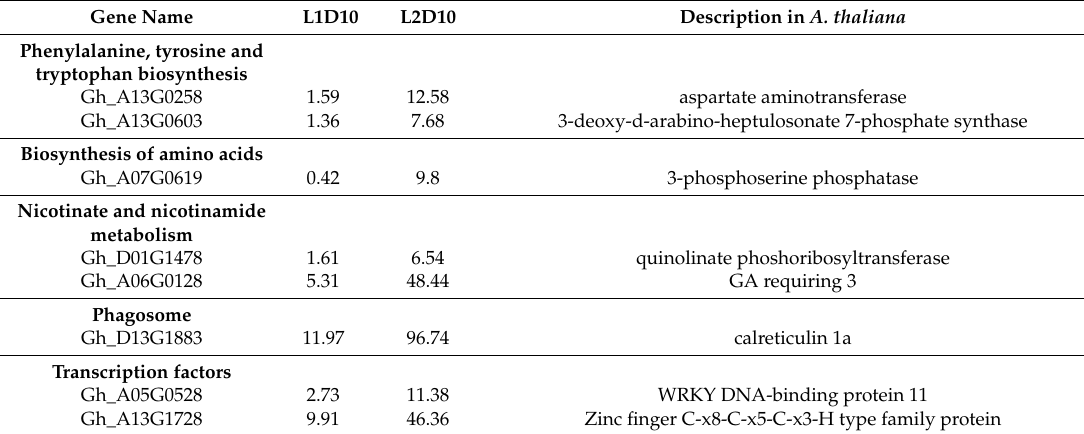
Table 2. FPKMs and functional categories of genes significantly down-regulated in L1 on 10DPA.